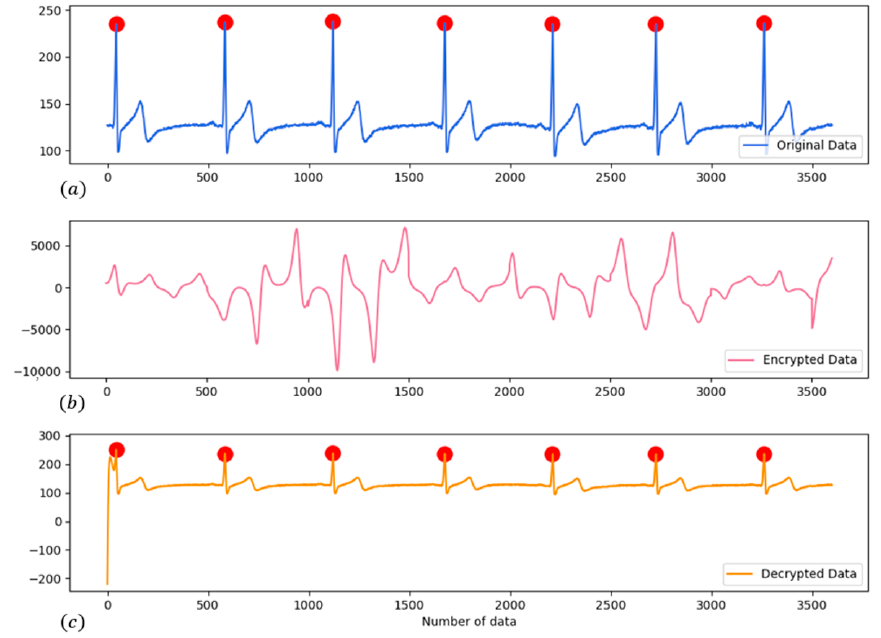
Figure 18. Simulation of heart rate. ( a ) The original data; ( b ) Encrypted data; ( c ) Decrypted data.